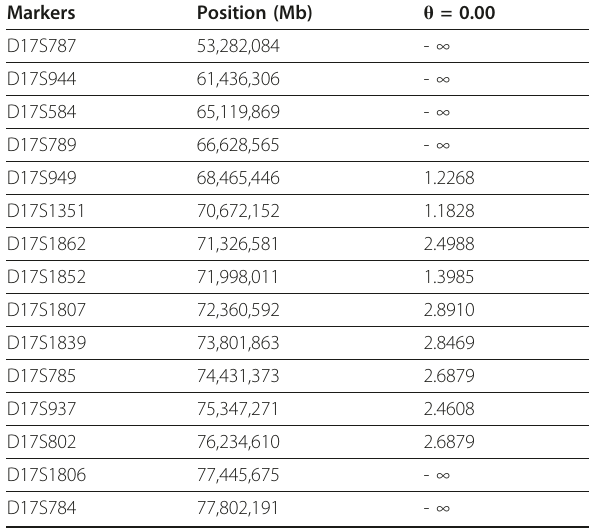
Table 1 Two point LOD score for microsatellite markers of family RBT-DAK calculated at recombination fraction